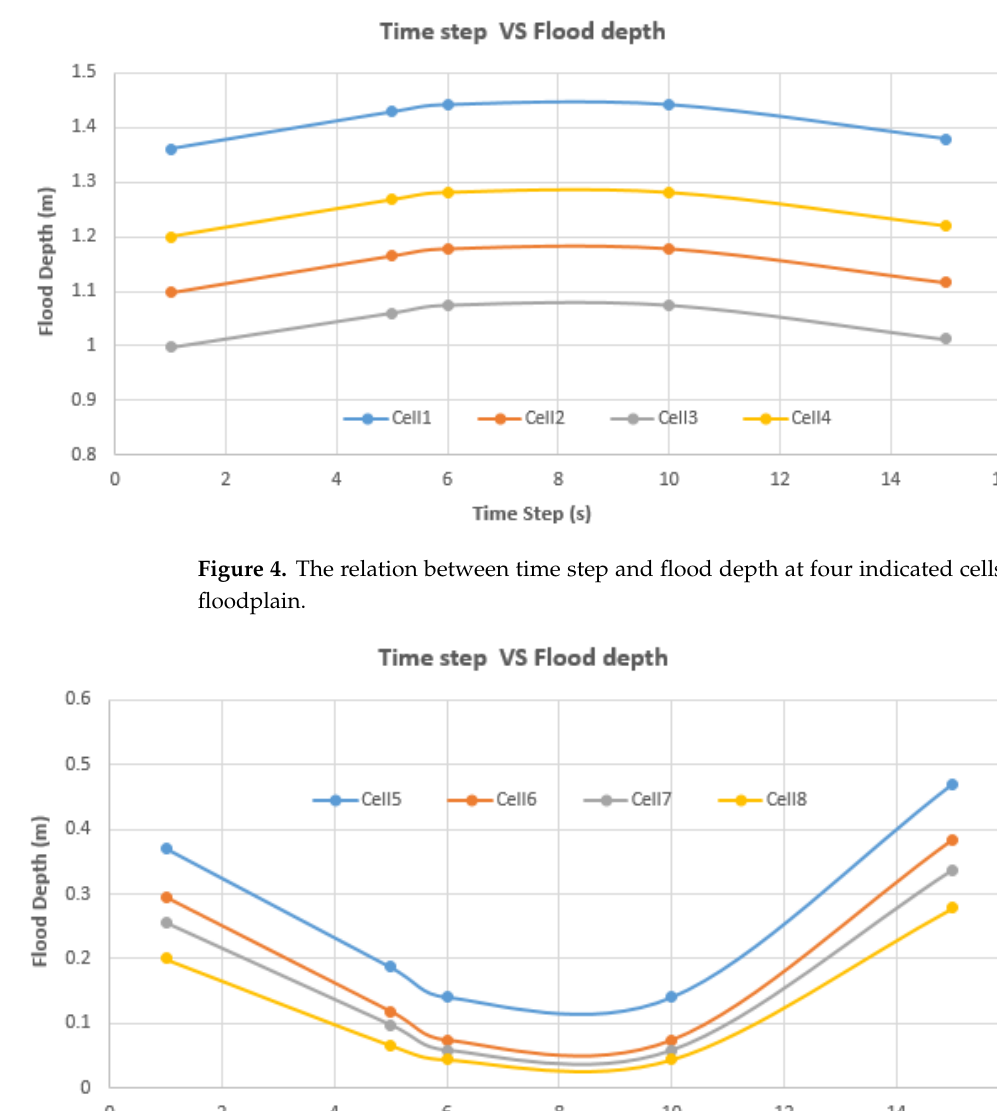
Table 3. Maximum flood depth values in different cells for certain cross sections in sub-reach K6. Cross Sections